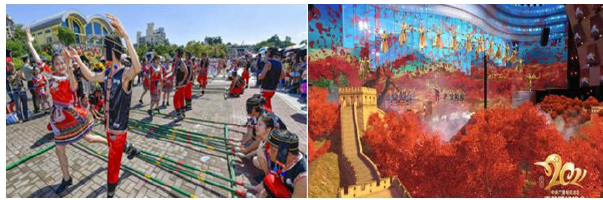
Fig. 8. Hainan Bamboo Pole Dance Show and AR